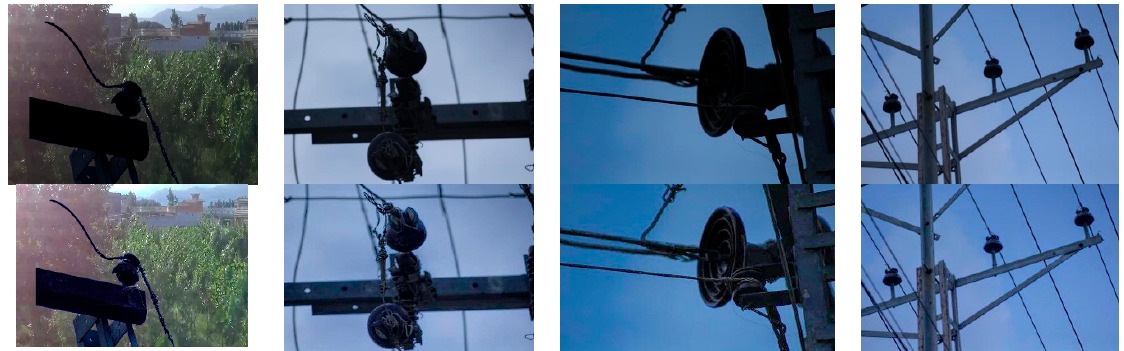
Figure 11. Low-light enhancement using LIME on different training